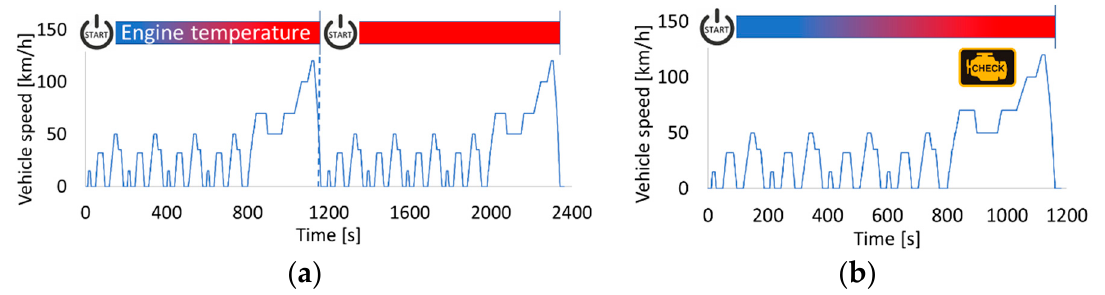
Figure 3. EU OBD legislation ( a ) first and second preconditioning cycles; ( b ) emission tests cycle (example of NEDC).